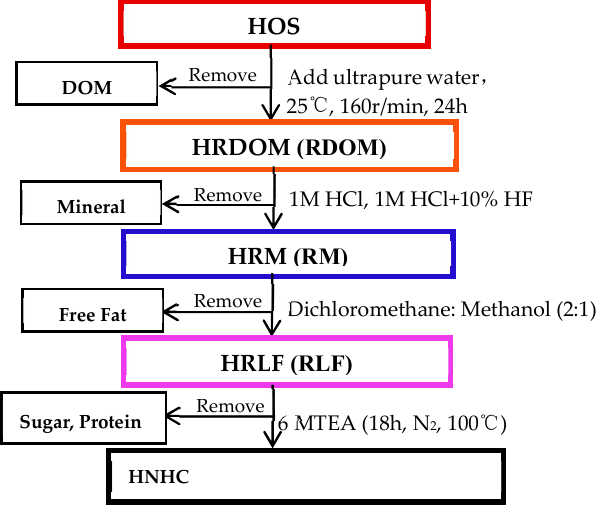
Figure 1. Extraction treatment of the organic matter of humus soil.